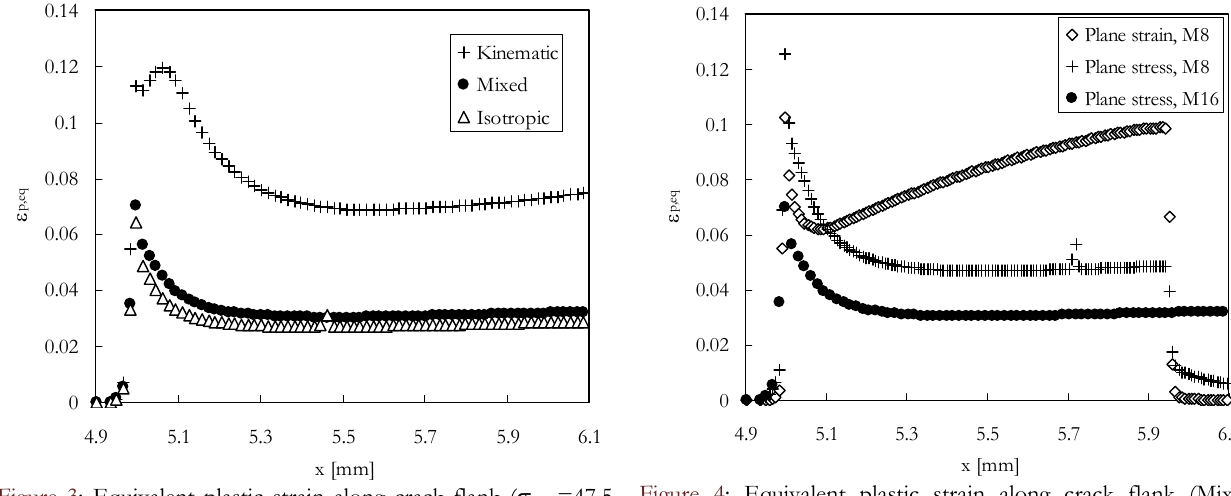
Figure 3: Equivalent plastic strain along crack flank (  max =47.5 MPa;  min =0.8 MPa, Mesh M16).